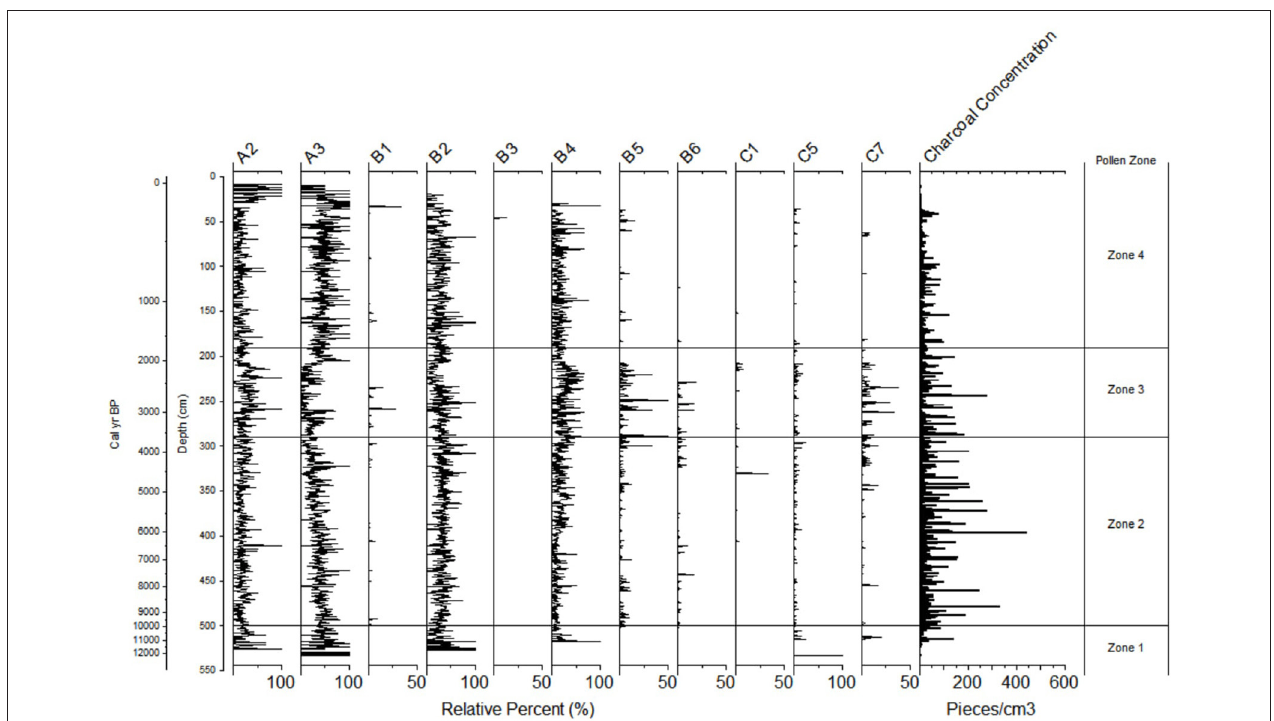
FIGURE 7 | Charcoal morphology for Spindly Pine Lake based on categories derived by Courtney Mustaphi and Pisaric (2014).